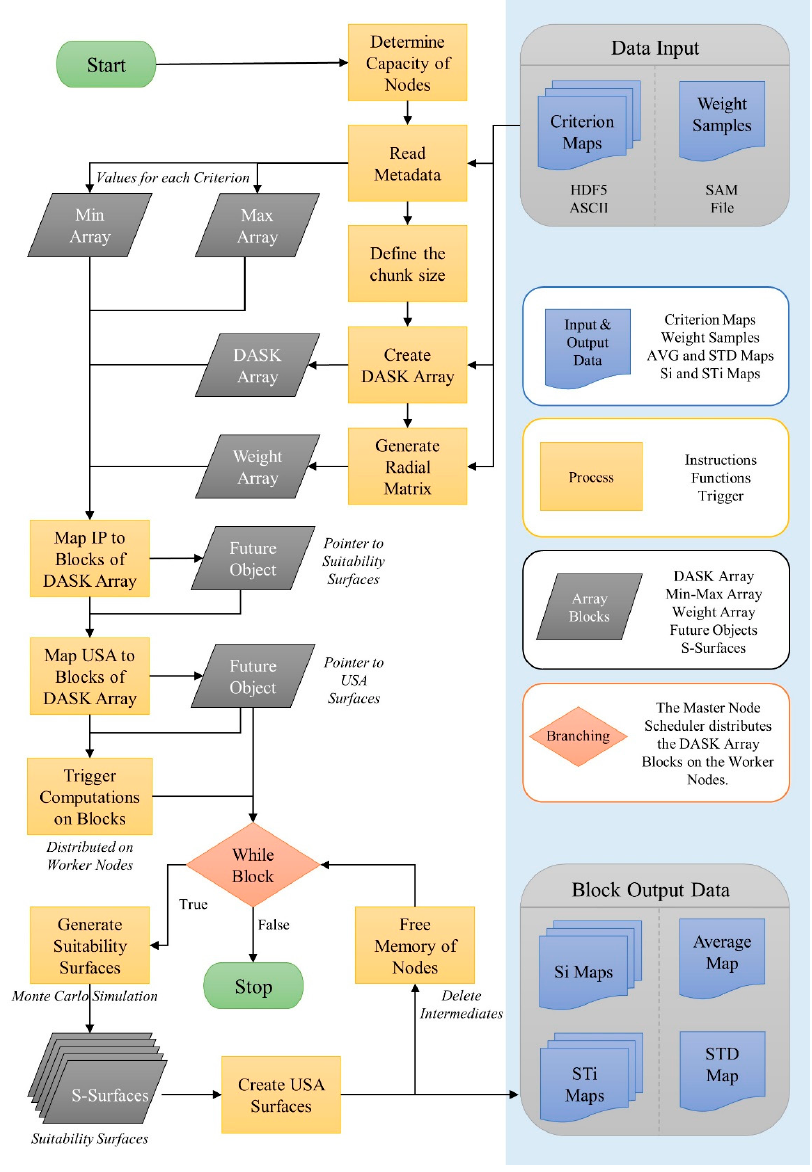
Figure 2. SEUSA–DASK workflow. Parallel and distributed SEUSA approach based on Python–DASK.